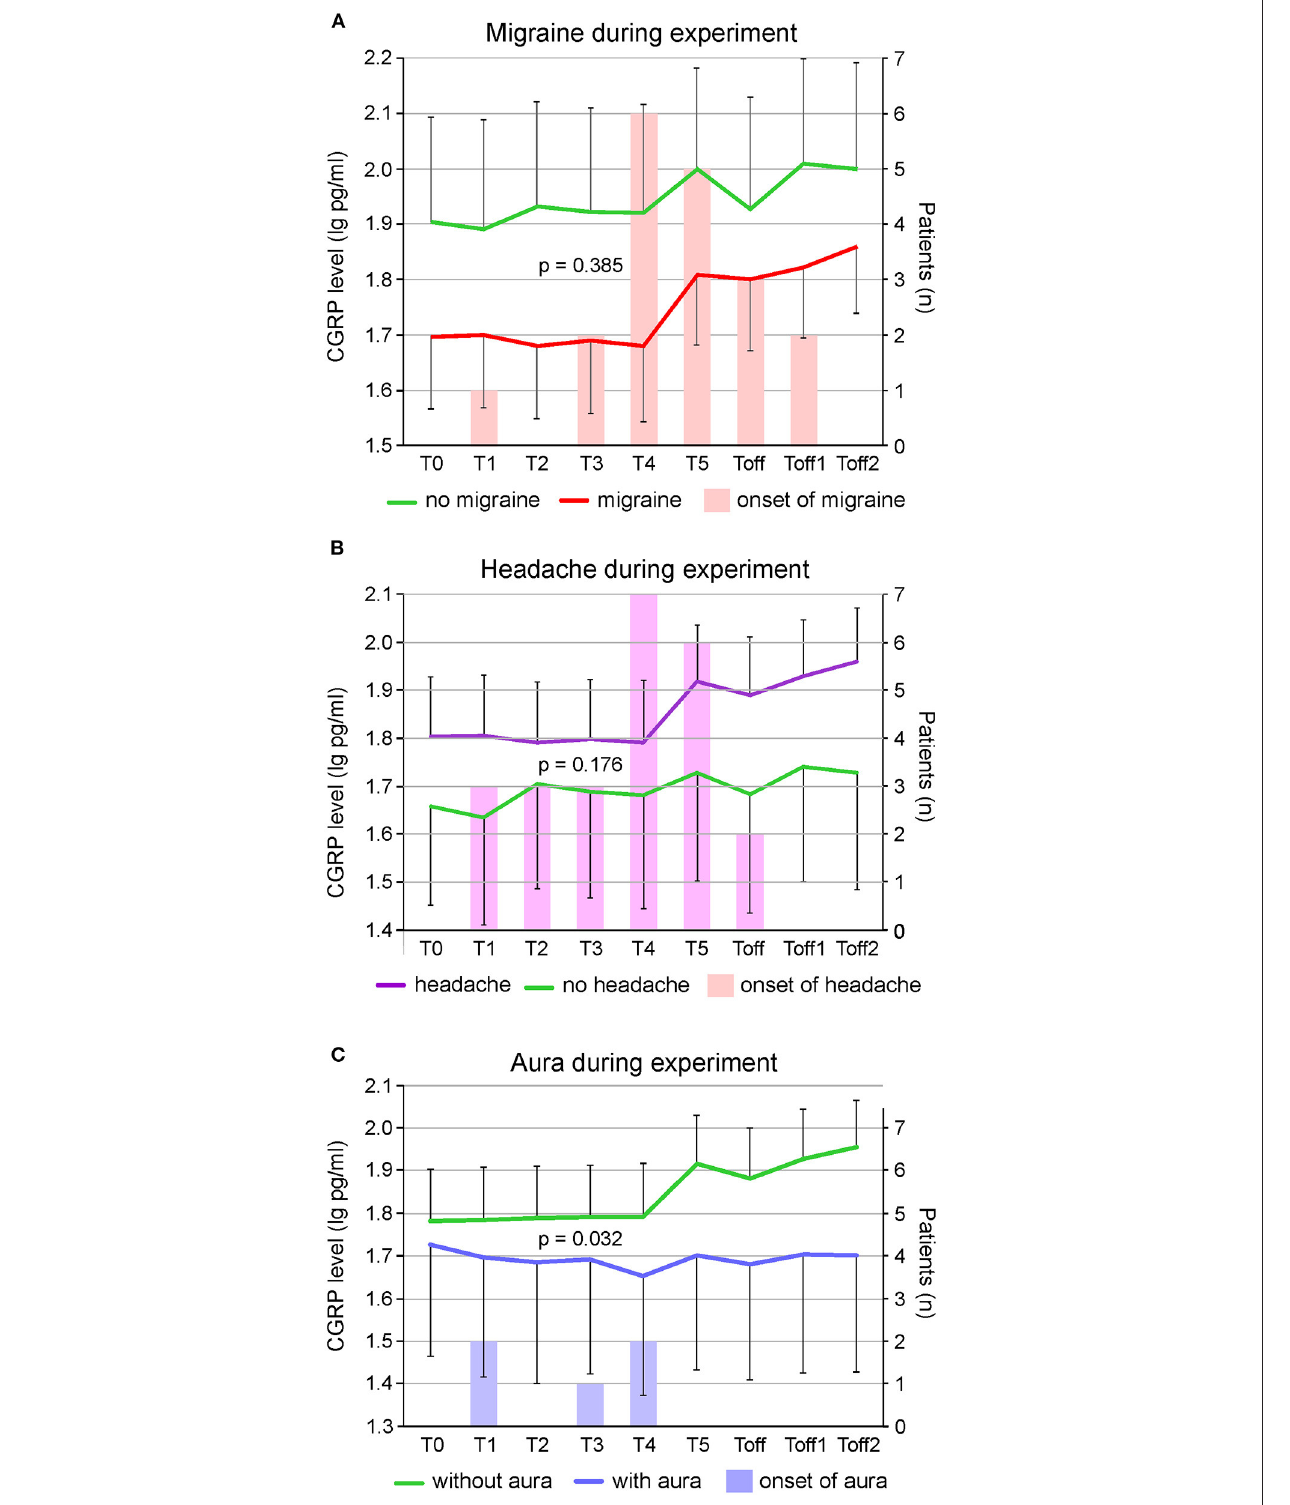
FIGURE 2 | Changes in logarithmized CGRP levels (pg/ml) over the time course of the experiment in participants with migraine ( n = 24) vs. no migraine ( n = 6) (A) , in subjects with (including migraine, n = 19) vs. without headache ( n = 11) (B) and subjects experiencing aura symptoms ( n = 5) vs. no aura